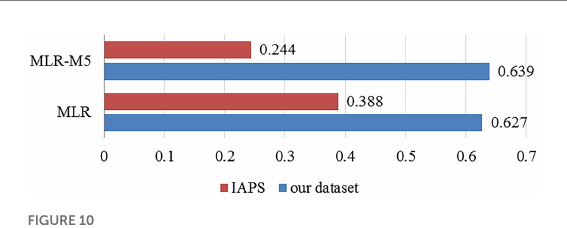
FIGURE 10 The comparison of the regression prediction results of the different datasets.